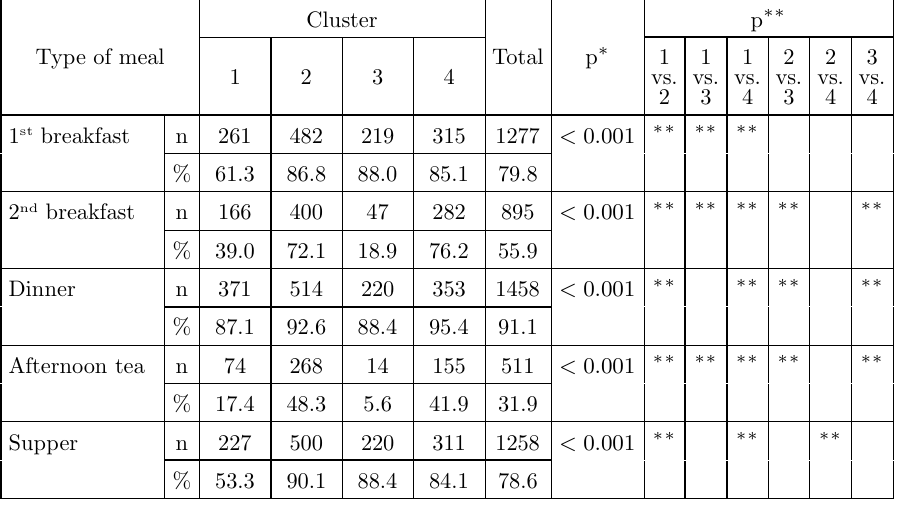
Table 5. Frequency of usual consumption of individual meals in separate clusters Cluster p ∗∗ Type of meal